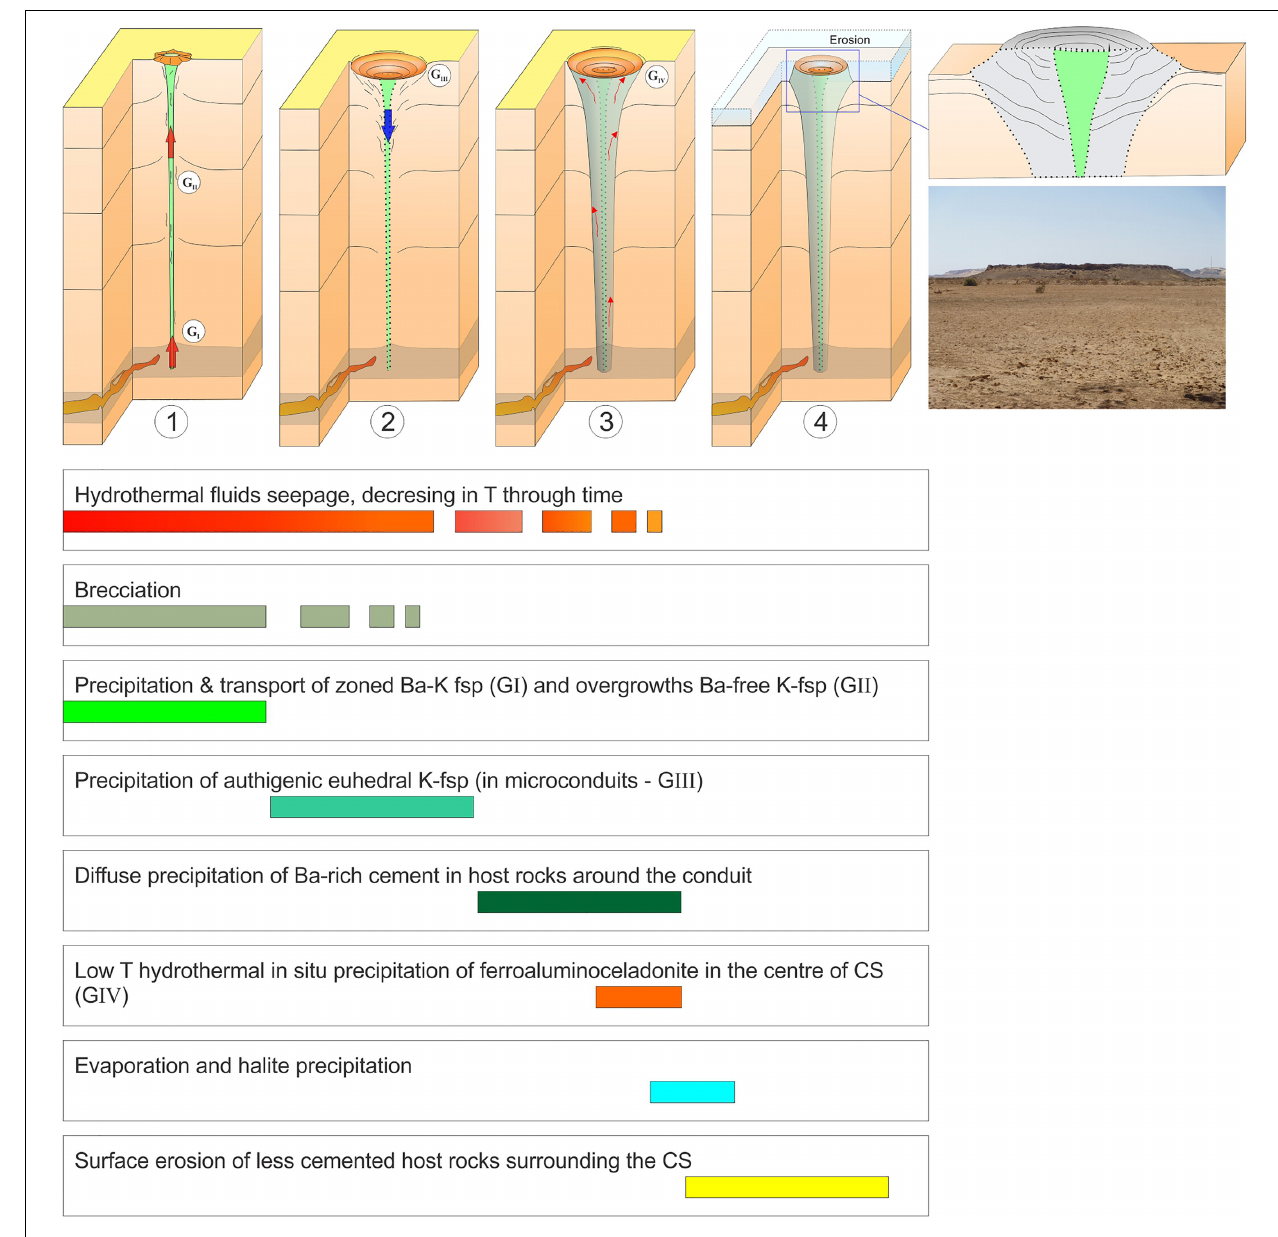
FIGURE 9 | Schematic cartoon (not to scale) of the proposed formation scenario for the CS. (1) hydrothermal venting (red arrow), brecciation of the formations within the conduit and deformation; (2) reduced venting activity, gradual sagging (blue arrow) and collapse of the conduit and inwards deformation; (3) slow hydrothermal seepage and minerals precipitation (red arrows) within the brecciated central part of the conduit and surrounding fractured areas; (4) erosion of the upper layers leaving exposed the cemented units around the crater with inwards collapse ring structures. Right: magnified crater zone and field example of CS.